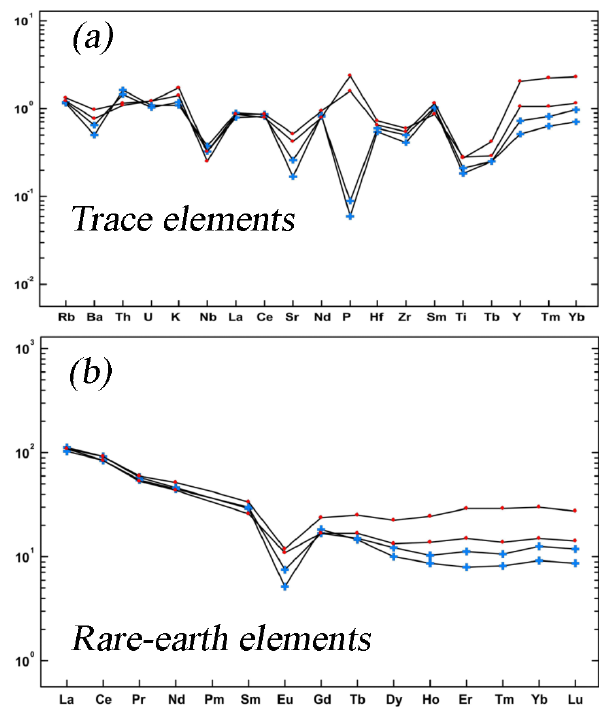
Figure 9. Concentrations of incompatible and rare-earth elements normalised to the composition of the upper crust (according to Tay- lor et al., 1981) and chondrite (for rare-earth elements, according to Sun and McDonough, 1989) in coprolites and source kudurites from the Solontsovsky palaeovolcano. Coprolite and kudurite data are denoted by points and crosses,